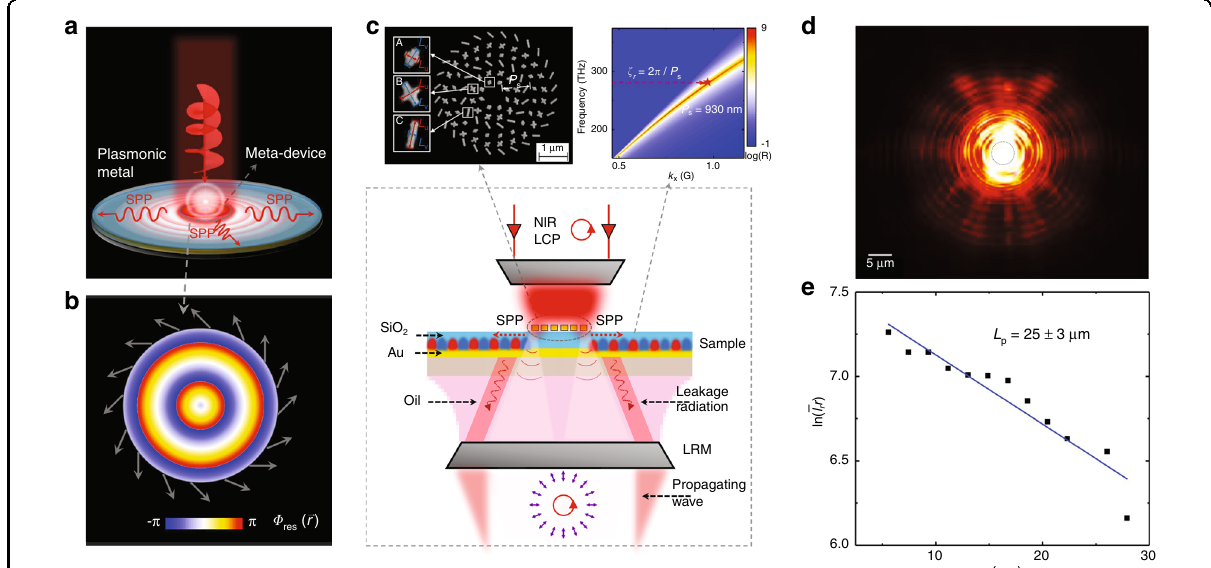
Fig. 7 Concept, sample, experimental setup and partial characterization of the vectorial vortex surface plasmon coupler. a Schematic of our proposed meta-device to generate a cylindrically polarized vortex SPP beam. b Color map representing the designed Φ res ð ~ r Þ distribution on the meta-device with surrounding arrows denoting the directions of ξ . c Schematic of our leakage radiation microscopy (LRM) setup. The upper left inset is an SEM image of the fabricated sample utilizing three different meta-atoms A, B and C (see all geometric parameters in Sec. 7.1 of the SI), and the upper right inset illustrates the dispersion of SPPs supported by the guiding-out plasmonic metal. d LRM-recorded image of the surface wave generated by our meta-device, which is illuminated by normally incident LCP light at a wavelength of 1064 nm. e Measured ln ð I r r Þ versus r (solid squares), fi tted with a linear relation (solid line) with the slope determining the SPP propagation